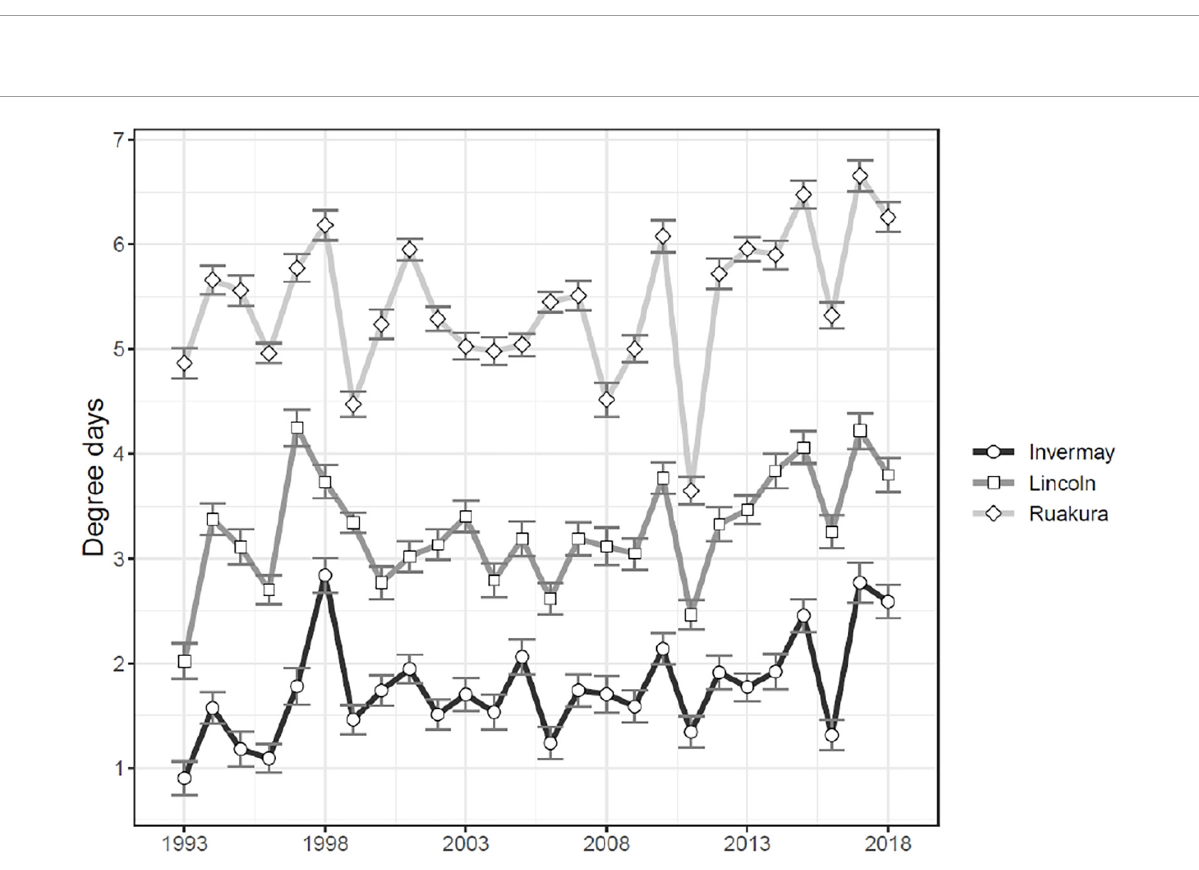
FIGURE2 Mean 24 h accumulation degree-days (DD) occurring above the 10.2 ◦ C development threshold of Microctonus hyperodae in the Southern Region (Locality: Invermay), the Central Region (Locality: Lincoln), and Northern Region (Locality: Ruakura) of New Zealand between November and June 1993–2018. Error bars represent the standard error of the mean daily DD occurring during the period of parasitoid